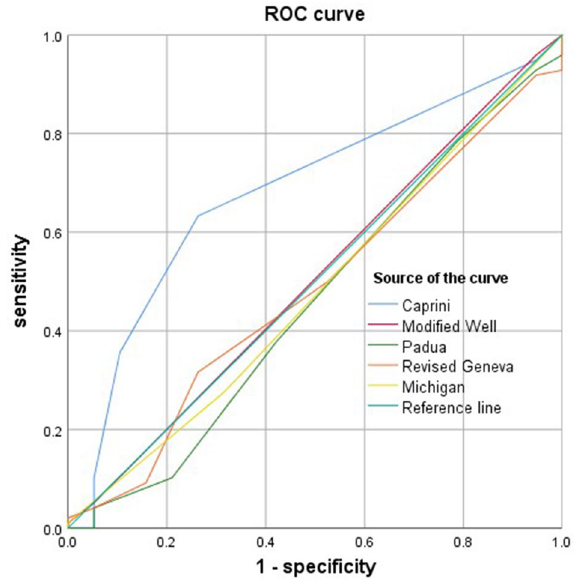
Figure 1. ROC curves of the five different thrombosis risk assessment scales.